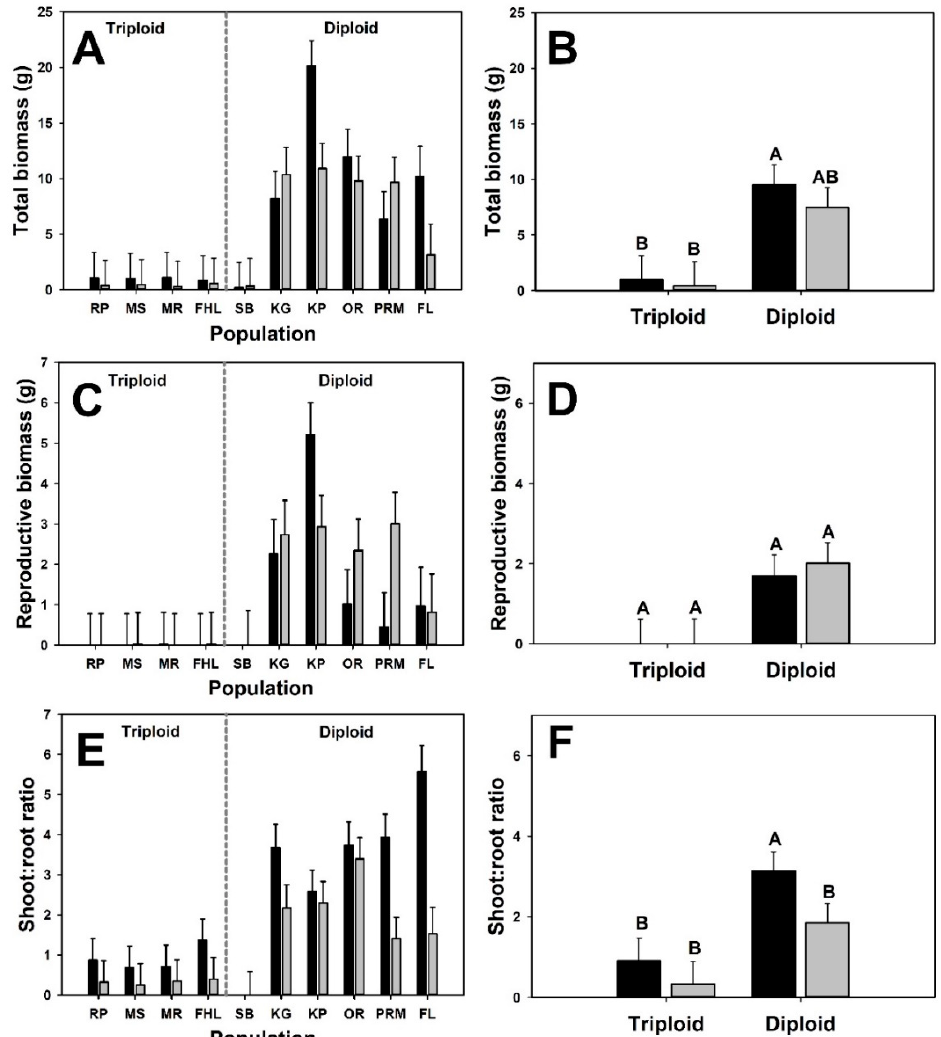
Figure 1. Biomass variables for the submersed interaction experiment. Black bars are mean values for plants growing in monoculture and gray bars are mean values of plants growing in experimental communities. Panels with population means ( A , C , E ) are presented to illustrate variation at the plant level, but statistics are presented for cytotype means only ( B , D , F ). Letters above bars represent distinct group means designated by Tukey post-hoc comparison.